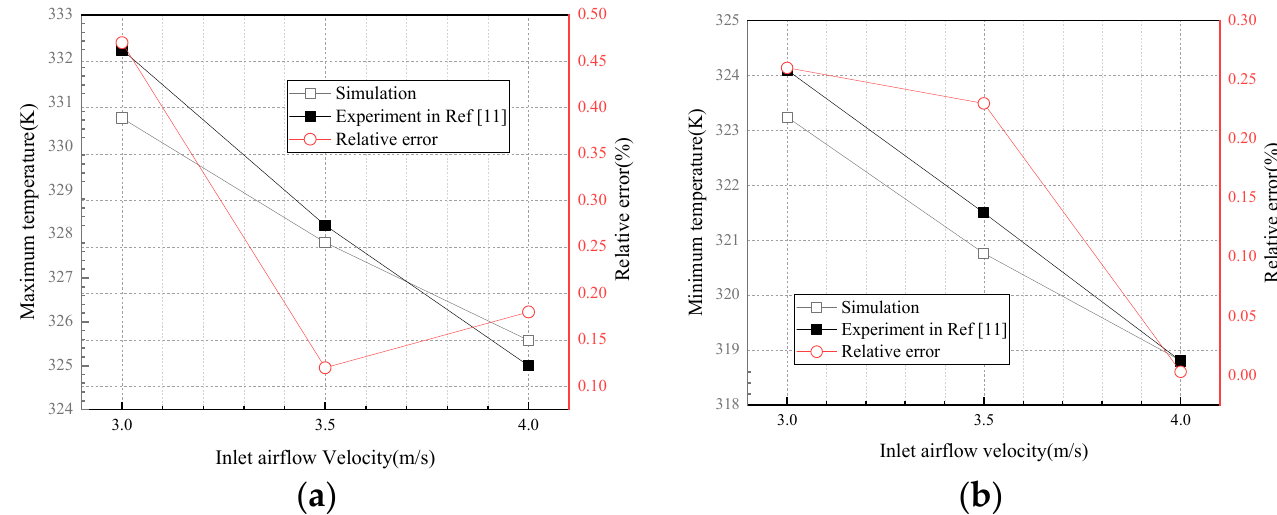
Figure 5. Comparison between the simulation results and experimental results; ( a ) maximum temperature and its relative error; ( b ) minimum temperature and its relative error.